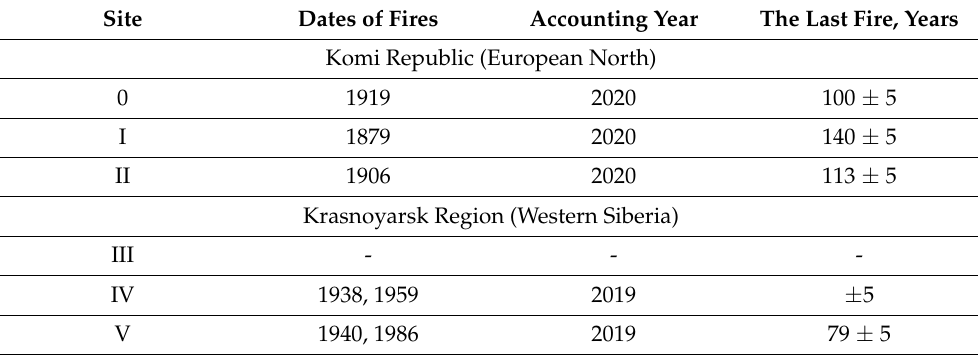
Table 2. Dendrochronological dating of peat (last